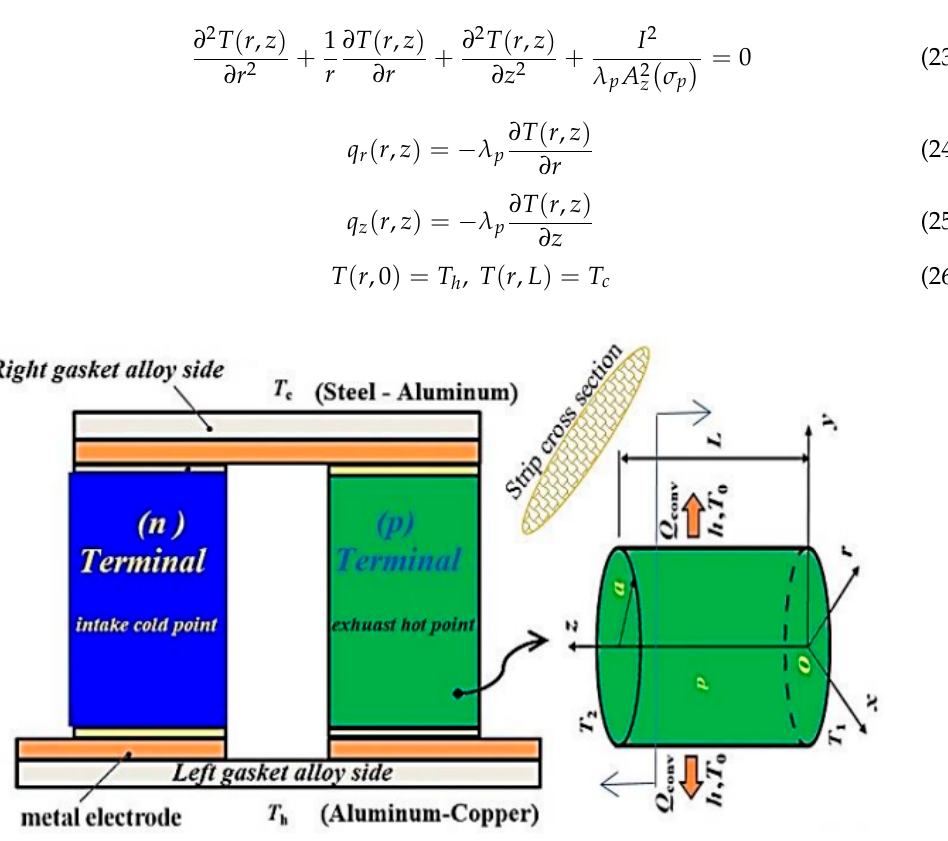
Figure 18. A thermoelectric generator with ellipsoid-cross section terminals.